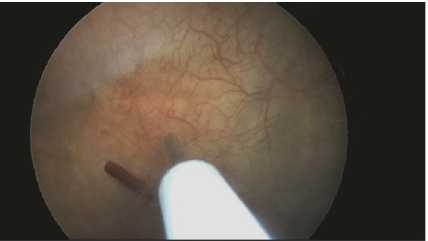
Figure 3: Needle retracting from uroepithelium, appropriate amount of bleeding noted.